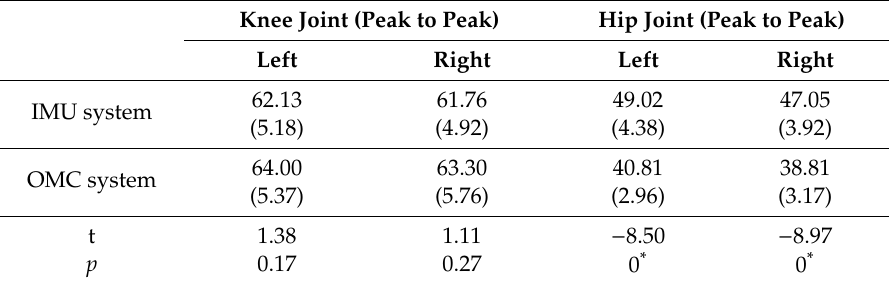
Values represent mean (±standard deviation). IMU: inertial measurement unit system; OMC: optical motion capture. * p < 0.05.